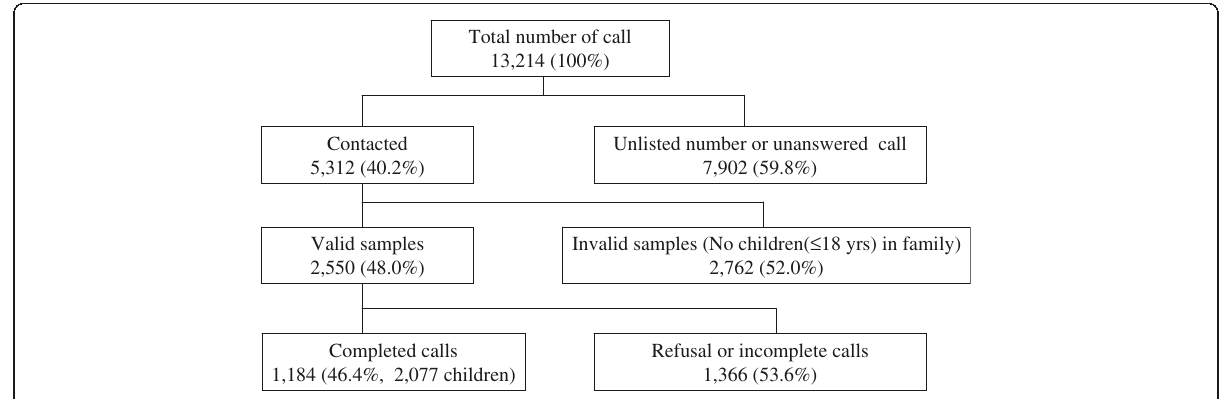
Figure 1 Overall response rate to the landline telephone